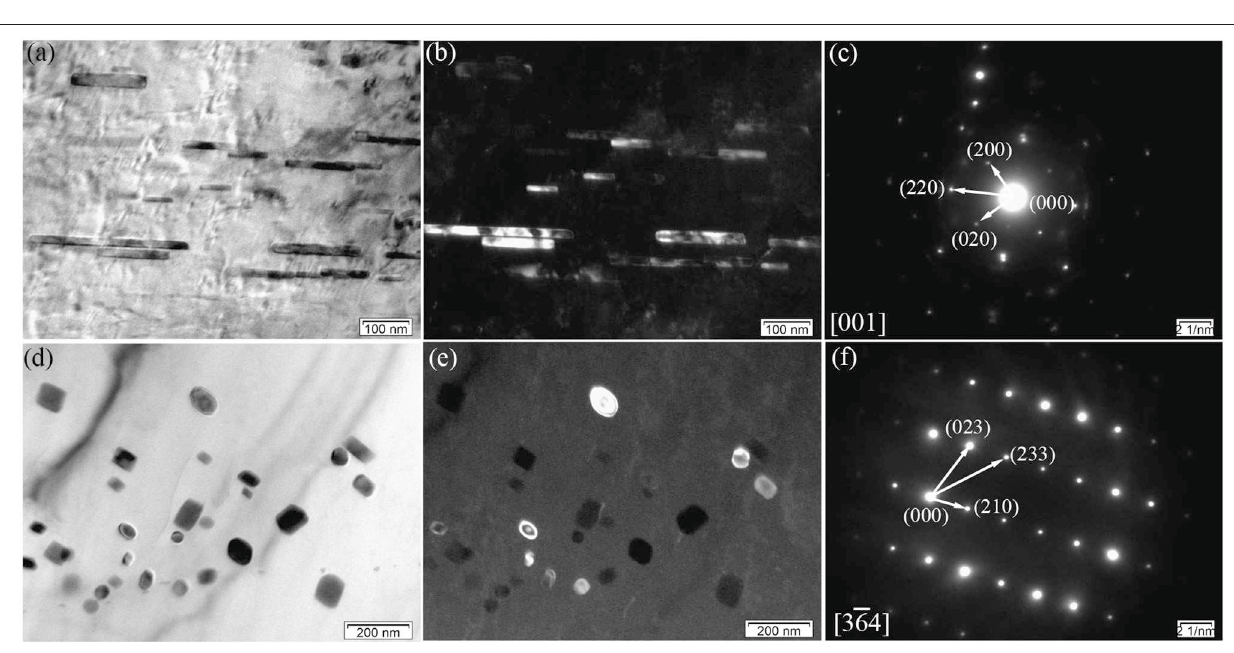
FIGURE 8 | Microstructure of the E350 sample; (a,b) BF and dark-field micrographs of the rod-like precipitates; (c) Corresponding SAED pattern of (a,b) ; (d,e) BF and dark-field micrographs of the grain-like precipitates; (f) Corresponding SAED pattern of (d,e)